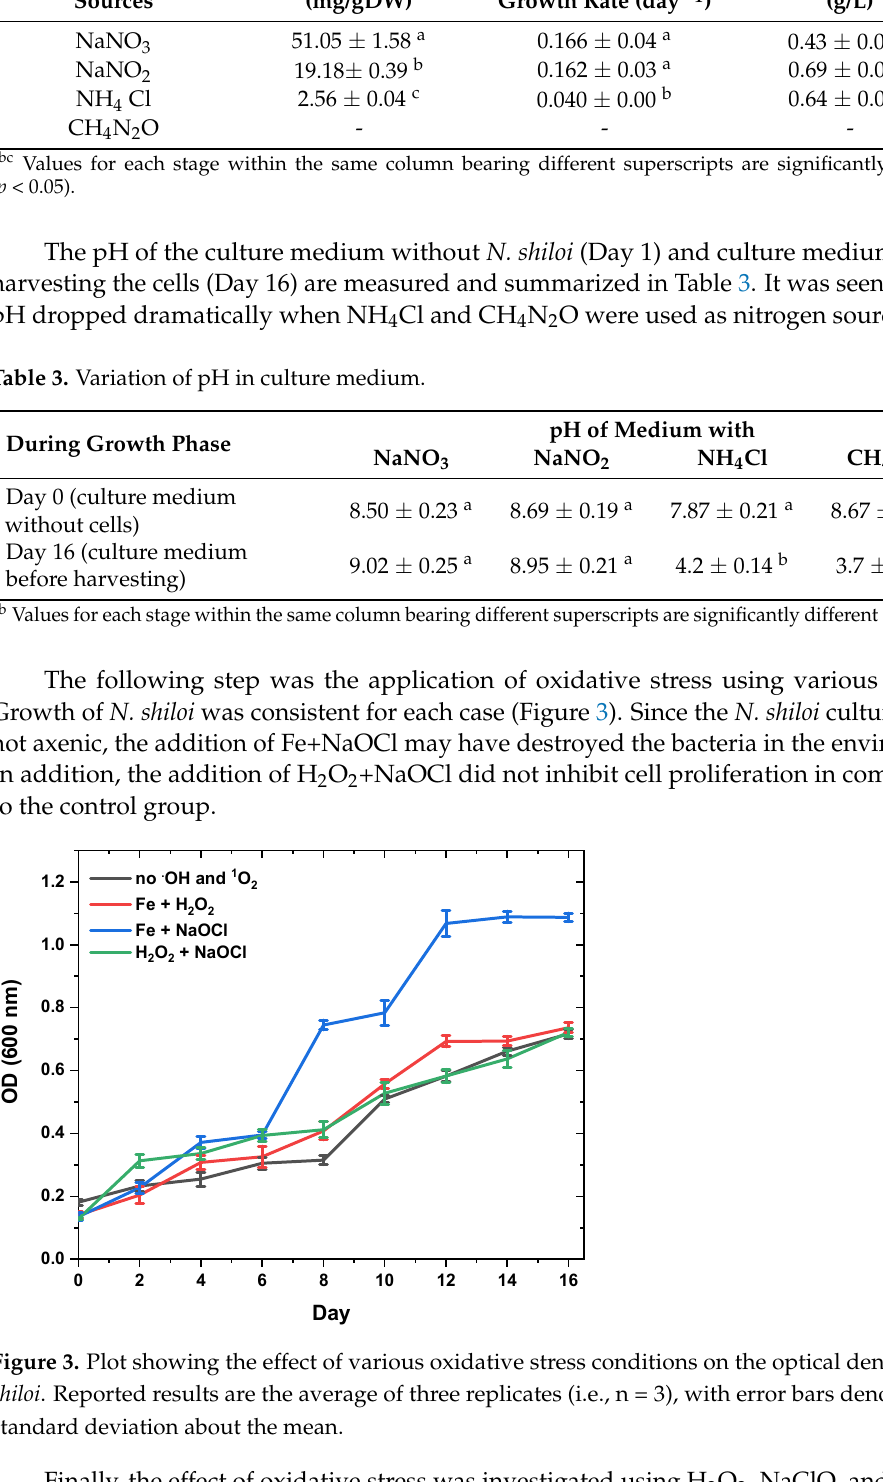
Table 4. Changes in biomass productivity of N. shiloi and variation in the fucoxanthin content under oxidative stress conditions. Oxidative Stress Sources in Seawaterbg-11